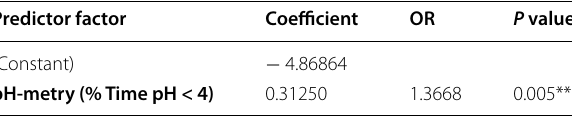
Table 4 Logistic regression model for the factors affecting LPR occurrence using Forward method